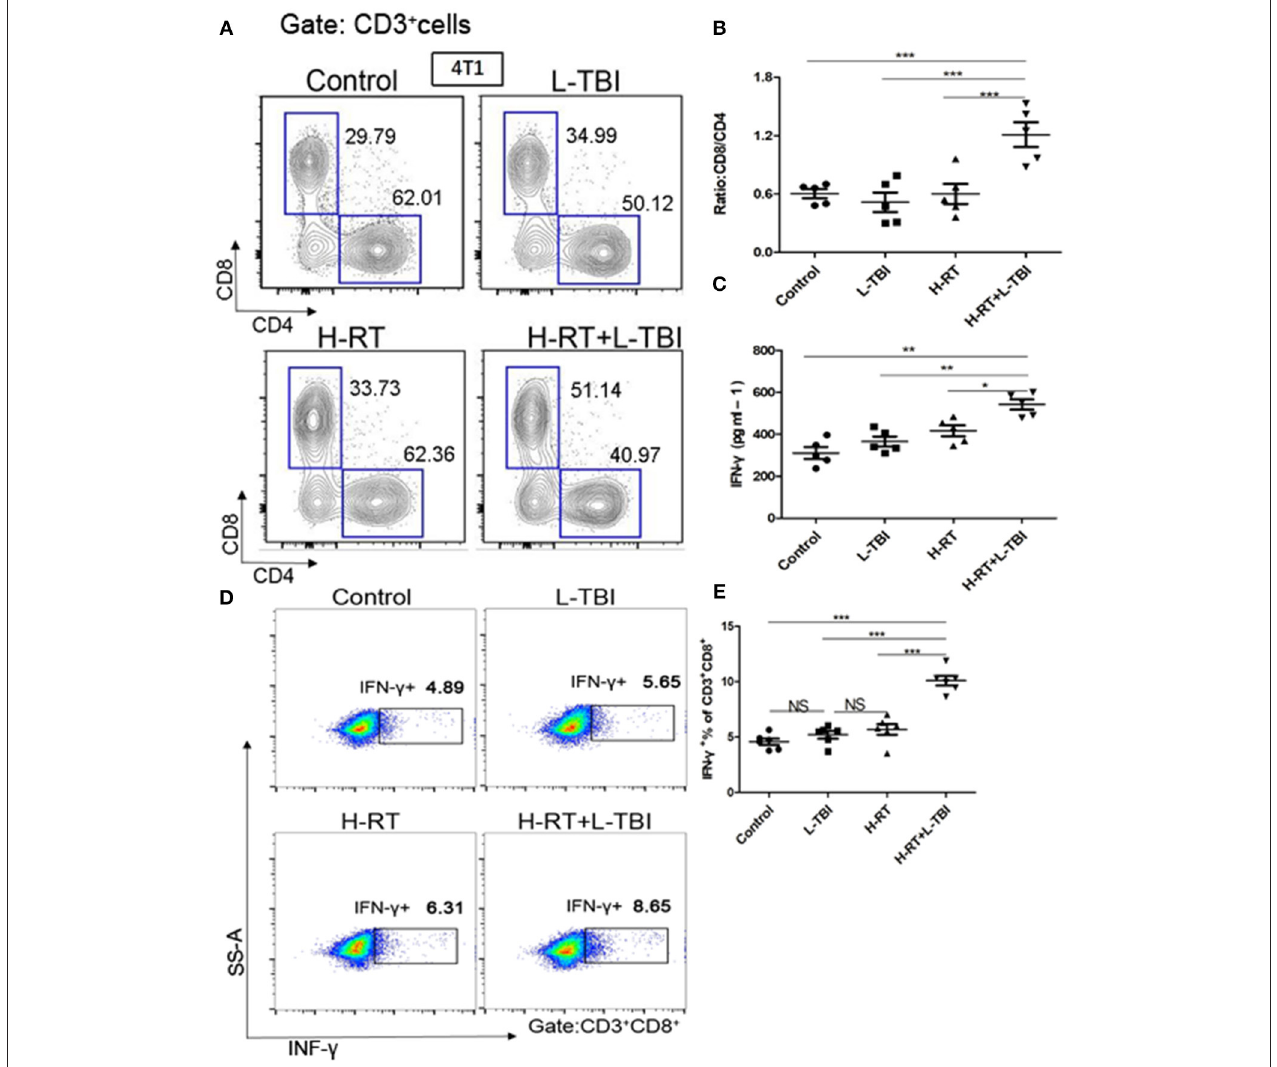
FIGURE 5 | Expression of CD8 + /CD4 + T cells in mice treated with H-RT and L-TBI radiotherapy. (A) The frequencies of CD8 + and CD4 + cells induced in the secondary tumor of each group ( n = 5 mice/group). (B) Ratio of CD8 + /CD4 + cells in the secondary tumor of each group ( n = 5 mice/group). (C) ELISA results of the INF- γ levels (pg/ml) in various groups ( n = 5 mice/group). (D) Representative dot plots of CD3 + CD8 + INF- γ + cells in the secondary tumor tissue of control, L-TBI, H-RT, and H-RT + L-TBI group ( n = 6 mice/group). (E) Comparison plot of CD3 + CD8 + INF- γ + cells in the secondary tumor tissue of different various groups ( n = 6 mice/group). The cells were gated on living lymphocytes and then on CD8 + and CD4 + cells and the percentages of CD3 + CD8 + INF- γ + T-cells were determined by flow cytometry analysis. Data are representative charts or the percentages of individual subjects. The lines indicate median values for each group. (* P < 0.05, ** P < 0.01, *** P < 0.001, NS = not